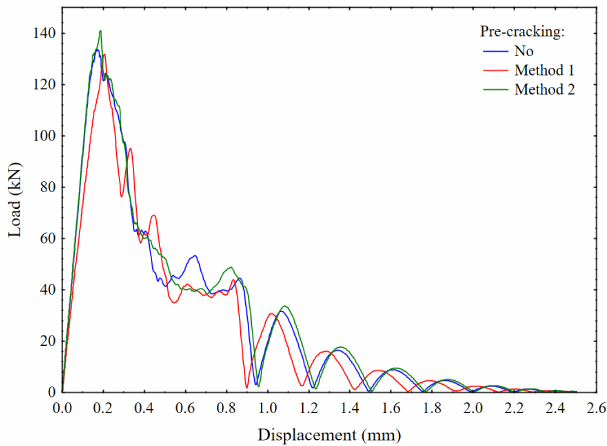
Figure 9. Load-displacement curves obtained for the pre-cracking tests on full MS CT